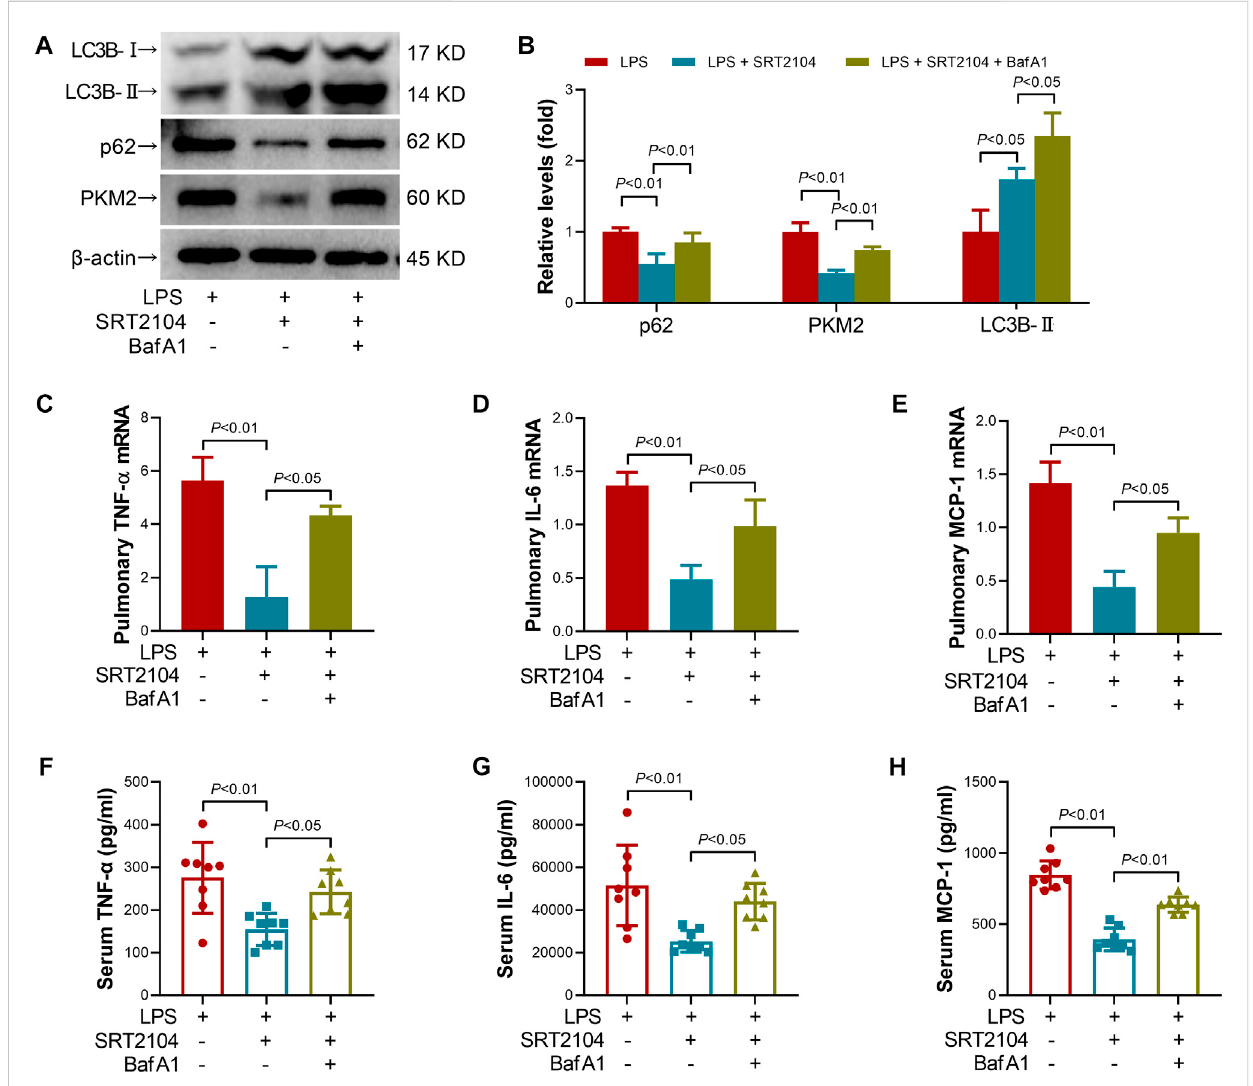
FIGURE 6 Lysosome inhibitor Ba fi lomycin A1 (BafA1) reversed the suppressive effects of SRT2104 on PKM2 and in fl ammation. C57BL/6 mice were challenged with LPS to induce systemic in fl ammation, vehicle or SRT2104 (25 mg/kg) was injected intraperitoneally with or without BafA1 (1 mg/kg) co- administration.Themiceweresacri fi ced8 hpostLPSexposure,andthelungsamplesaswellasserumsampleswerecollected. (A,B) Theproteinlevelsof LC3B-II, p62 and PKM2 in lung tissues were determined, n = 4. (C – E) The mRNA levels of (C) TNF- α , (D) IL-6 and (E) MCP-1 in lung tissues were determined, n = 3. (F – H) The serum levels of (F) TNF- α , (G) IL-6 and (H) MCP-1 were determined, n = 8. Data were expressed as means